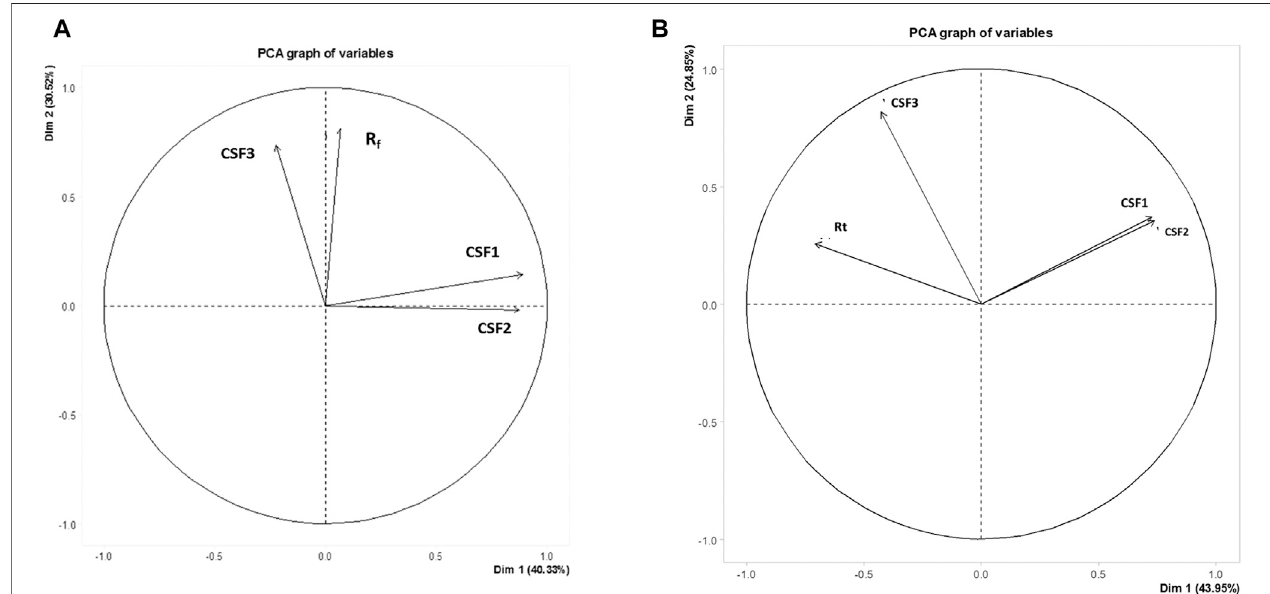
FIGURE 6 | Variables factor map depicting variances among CSF1, CSF2 and CSF3 extracts on basis of HPTLC (A) and GC-MS (B) metabolite pro fi ling. Similarities were observed between CSF1 and CSF2, the supercritical extracts prepared using ethanol as co-solvent, owing to their close presence in same quadrant. CSF3 occurred on a separate quadrant from the former. R f , retardation factor value of metabolites detected by HPTLC; R t , retention time of VOCs identi fi ed by GC-MS.